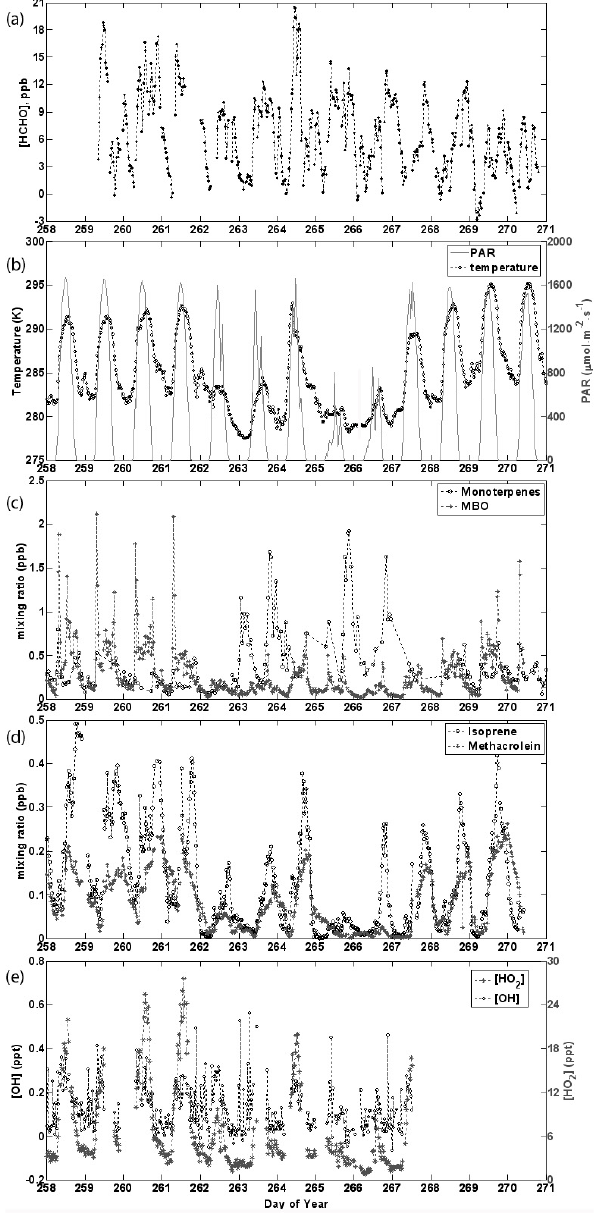
Fig. 4. Timeseries of (a) HCHO, (b) temperature and PAR, (c) total monoterpenes and MBO, (d) isoprene and methacrolein, and (e) HO x during days 258 ∼ 271 of BEARPEX 2007. All data points are 30min average.